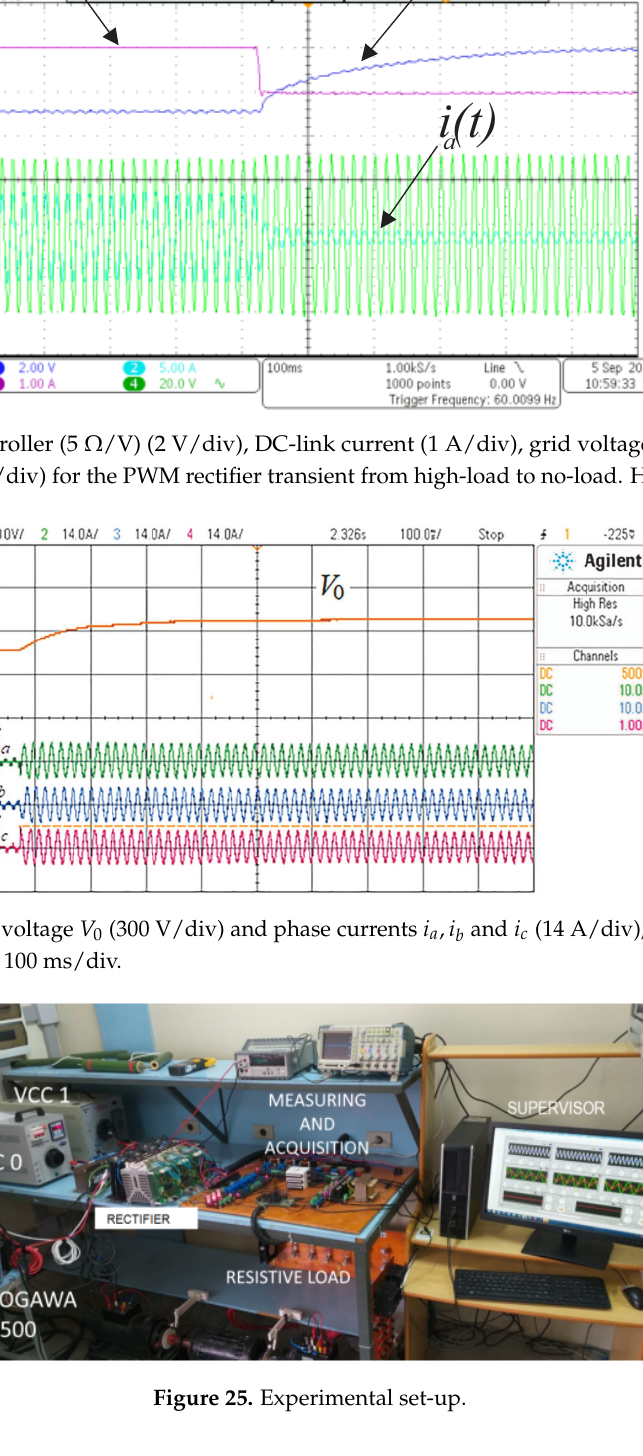
Figure 25. Experimental